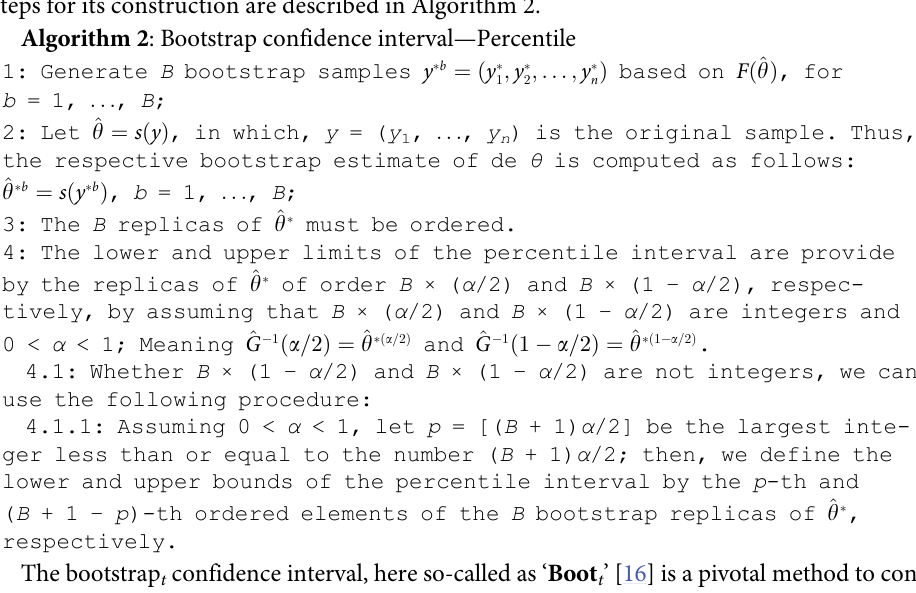
Algorithm 2 : Bootstrap confidence